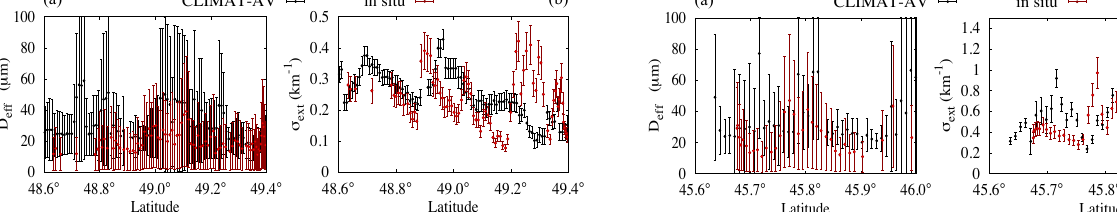
Fig. 11. Effective diameter (a) and visible coefficient (b) retrieved from the GF20 instruments (in red) and by our methodology us- ing CLIMAT-AV measurements (in black) for the 25 May 2007 leg presented in Fig.